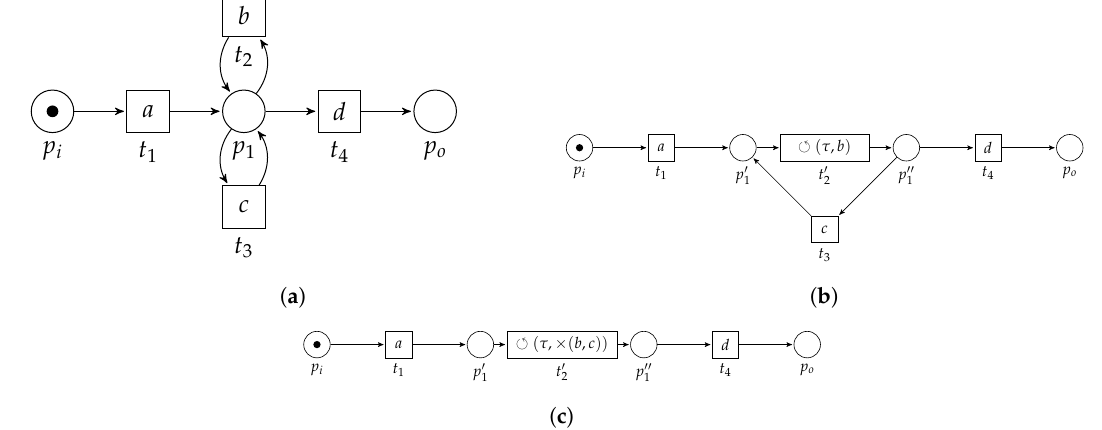
Figure 16. Example application of the self-loop pattern reduction. ( a ) Simple WF-net, having self loop transitions t 2 and t 3 . ( b ) Self-loop reduction where T (cid:48) = { t 2 } . ( c ) Self-loop reduction where T (cid:48) = { t 2 , t 3 }